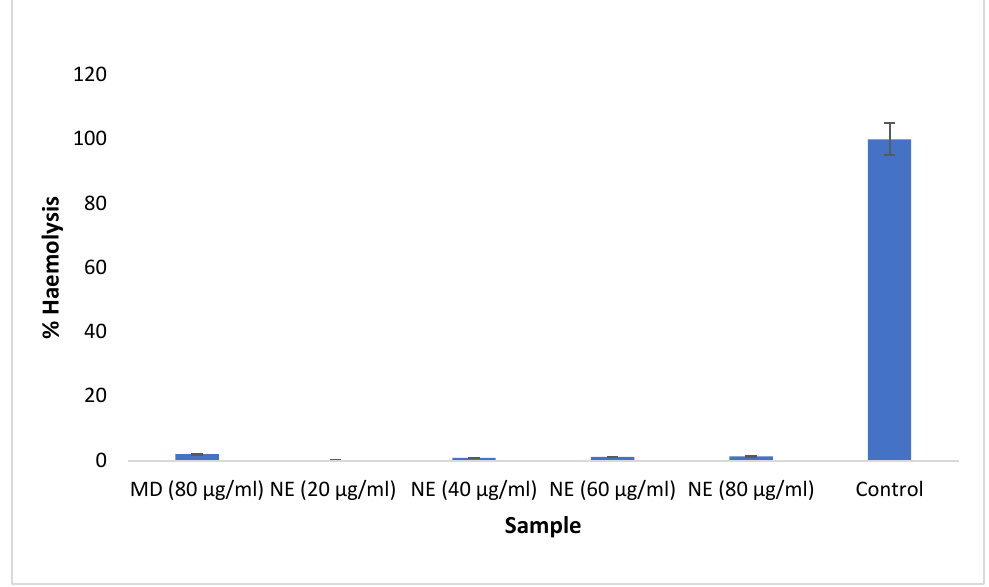
Figure 9. Percentage hemolysis of methotrexate-loaded nanoemulsion and pure methotrexate solu- tion. NE: Methotrexate-loaded nanoemulsion; MD: Marketed drug.